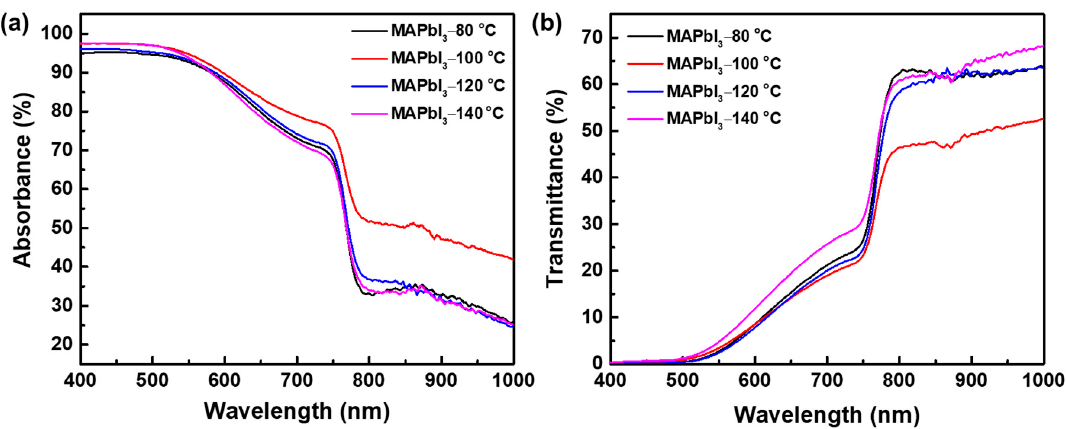
Figure 5. ( a ) Absorbance and ( b ) transmittance spectra of MAPbI 3 at annealing temperatures of 80, 100, 120, and 140 °C.